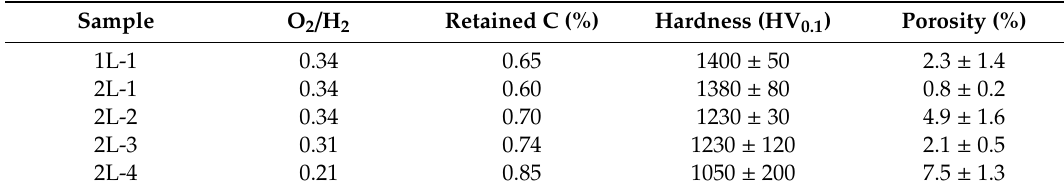
Table 3. Characteristics of the coatings deposited.